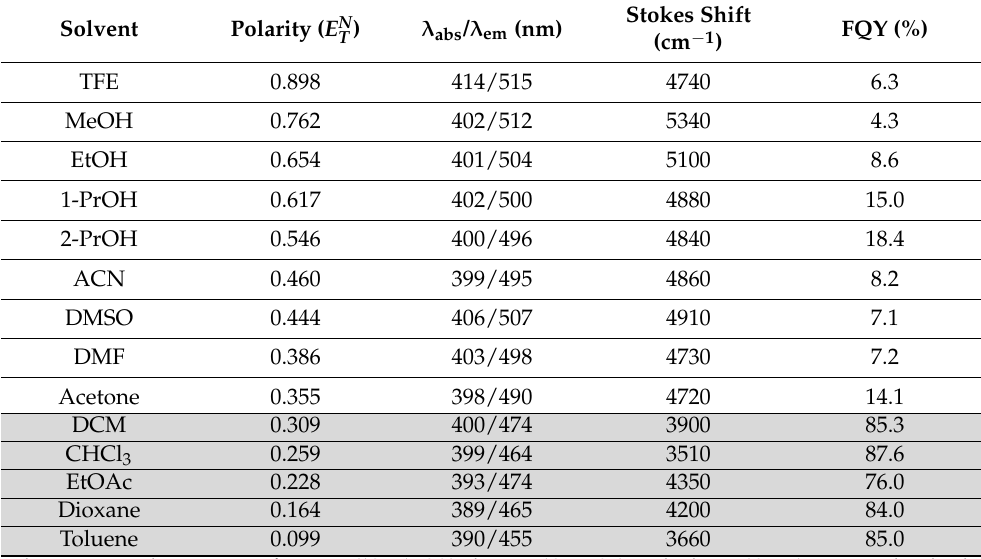
Table 1. Solvatochromism and FQYs of C481 in 14 solvents with different polarities (solvents with significantly higher FQYs are highlighted by light gray shades) *.